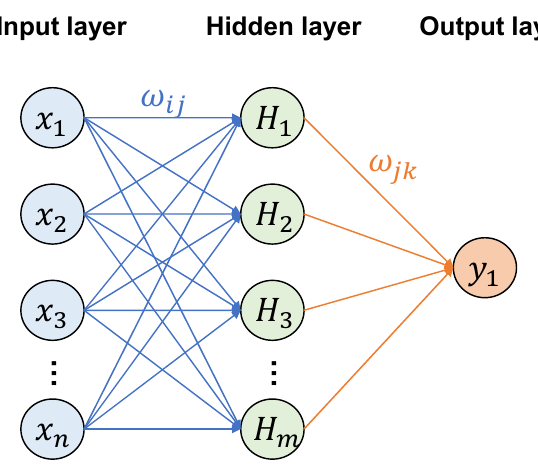
Figure 1. Neural network structure.